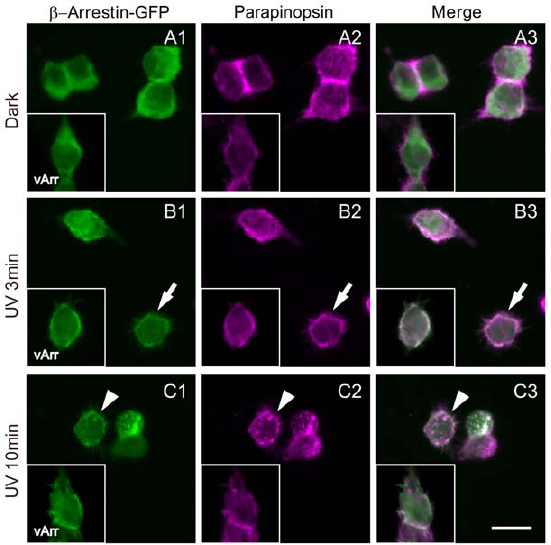
Figure 3. Light-induced translocation of b -arrestin with para- pinopsin in cultured cells. HEK 293S cells expressing lamprey parapinopsin and lamprey b -arrestin-GFP before irradiation (A) and 3 min (B) and 10 min (C) after irradiation with UV light. Panels Ai-Ci and panels Aii–Cii show fluorescence images of b -arrestin-GFP (green) and parapinopsin immunoreactivity (magenta), respectively. The inset of each figure shows the HEK 293S cells expressing lamprey visual arrestin- GFP (Ai–Ci inset, green) and lamprey parapinopsin (Aii–Cii inset, magenta) under the same light conditions. Panels Aiii–Ciii are merged images. Note that b -arrestin-GFP translocated to the cell membrane after UV irradiation (arrows) and subsequently appeared as granules also containing parapinopsin in the cytoplasm (arrowheads). In the HEK 293S cells expressing visual arrestin-GFP and parapinopsin, visual arrestin translocated to the cell membrane but was not observed in the intracellular granules after irradiation with UV light (inset). Scale bar, 10 m m.